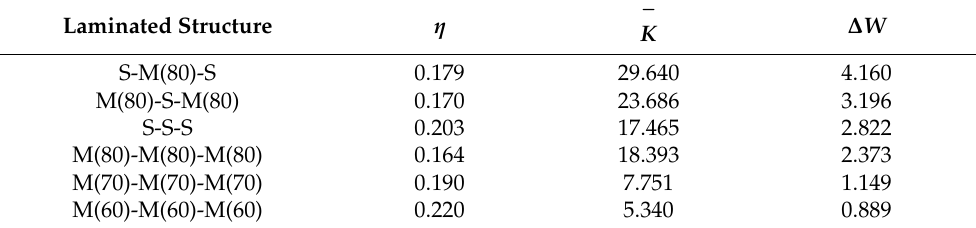
Figure 9. Hysteretic curves of the different laminated structures. Table 5. Variation in the damping characteristics of each laminated structure.